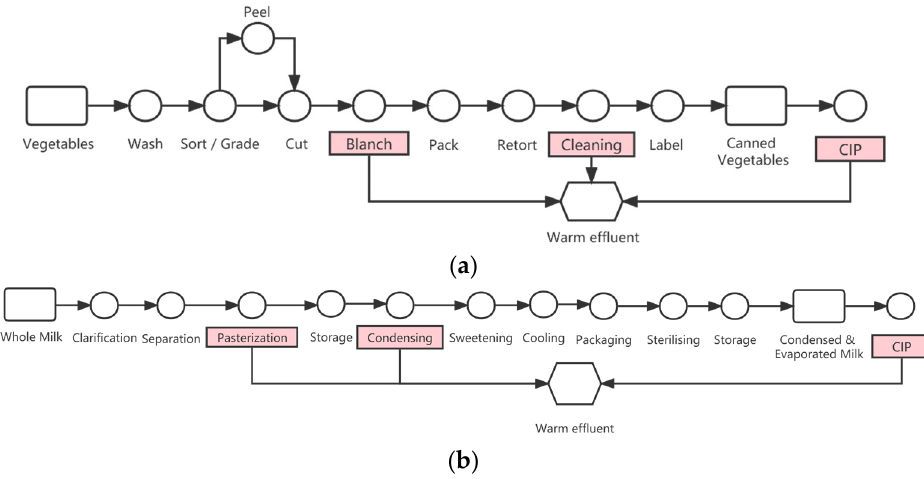
Figure 2. Process flow diagram for producing ( a ) canned vegetables and ( b ) condensed and evaporated milk .